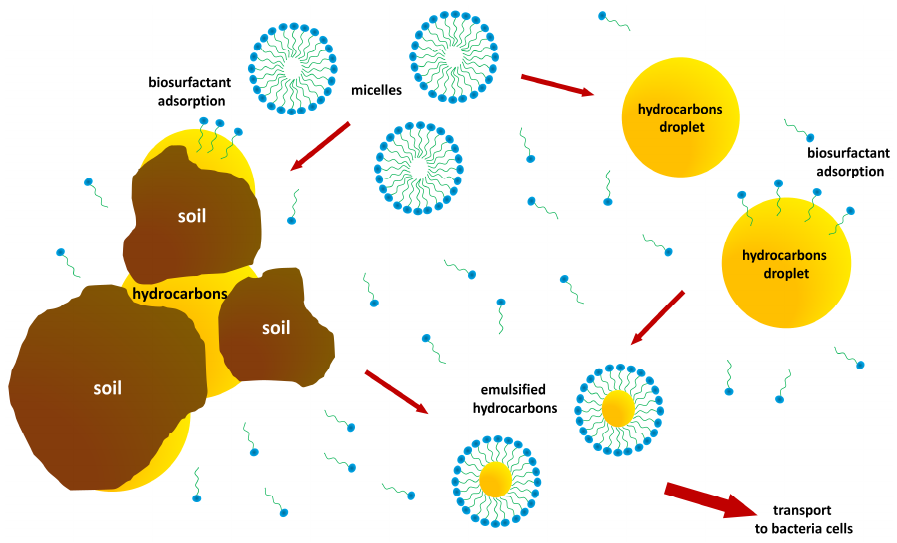
Figure 2. Main mechanisms of hydrocarbons desorption and emulsification enhanced with biosurfactants.